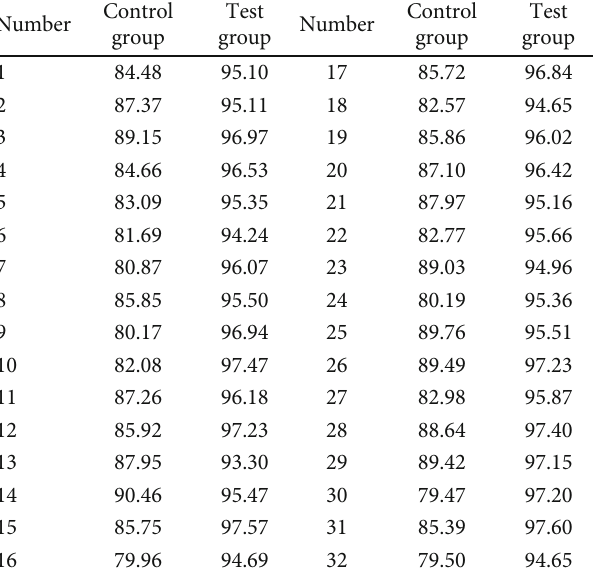
Table 4: Comparison of VAS scores between the two groups of patients after treatment.